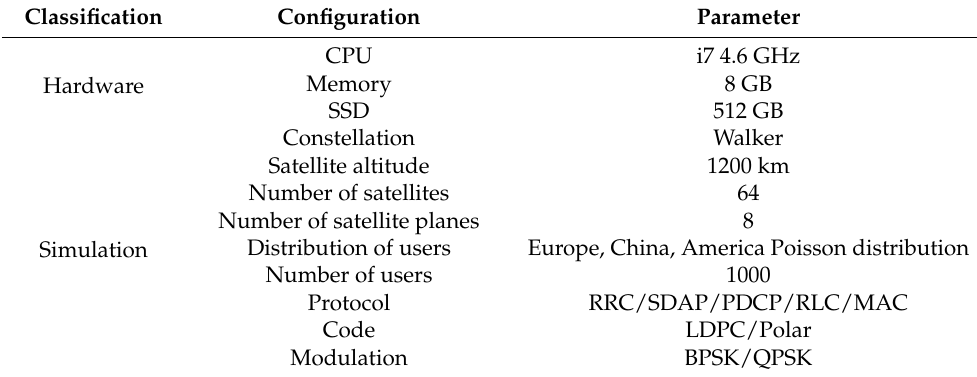
Table 1. Simulation parameters